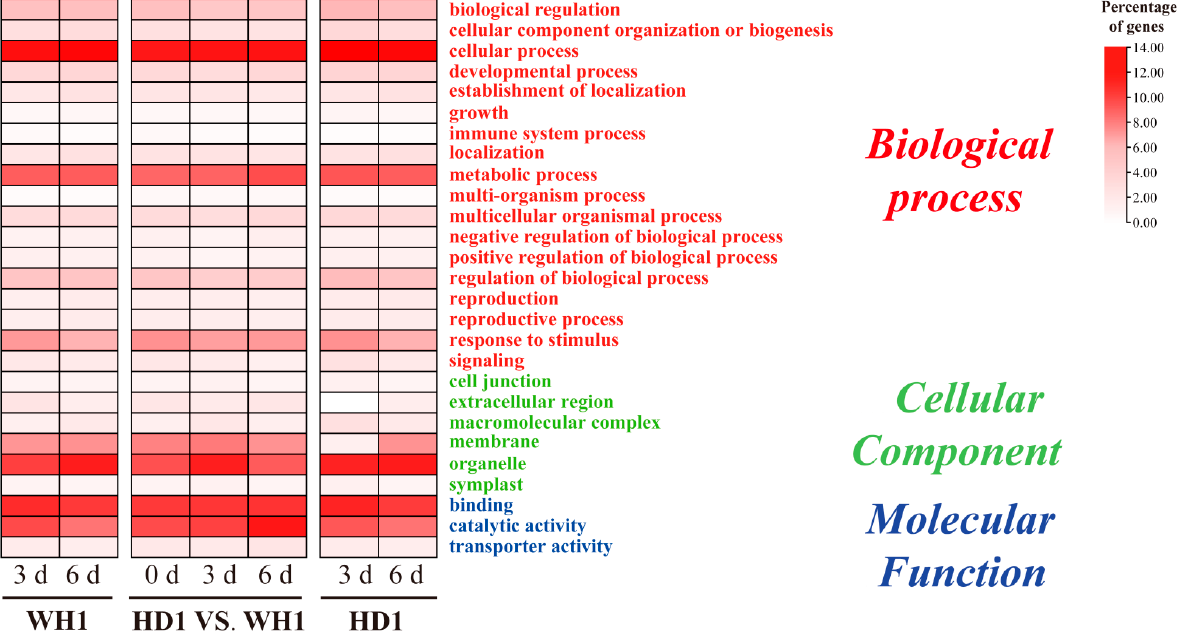
Figure 4. Functional annotations based on C. vietnamensis GO term analysis. The results are classified into three major GO classes, namely, biological process (BP), cellular component (CC) and molecular function (MF). Blocks from left to right indicate the GO term from comparisons of WH1-0d vs. WH1-3d, WH1-0d vs. WH1-6d, HD1-0d vs. WH1-0d, HD1-3d vs. WH1-3d, HD1-6d vs. WH1-6d, HD1-0d vs. HD1-3d, and HD1-0d vs. HD1-6d. According to KEGG analysis, DEGs identified in HD1-0d vs. WH1-0d, HD1-3d vs. WH1-3d and HD1-6d vs. WH1-6d were enriched in 105, 98 and 75 pathways, respectively HD1-0d vs. HD1-3d and HD1-0d vs. HD1-6d were enriched in 92 and 122 KEGG path-